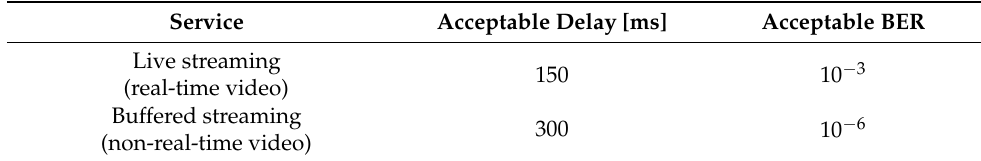
Table 3. Basic video transmission services with their technical requirements.